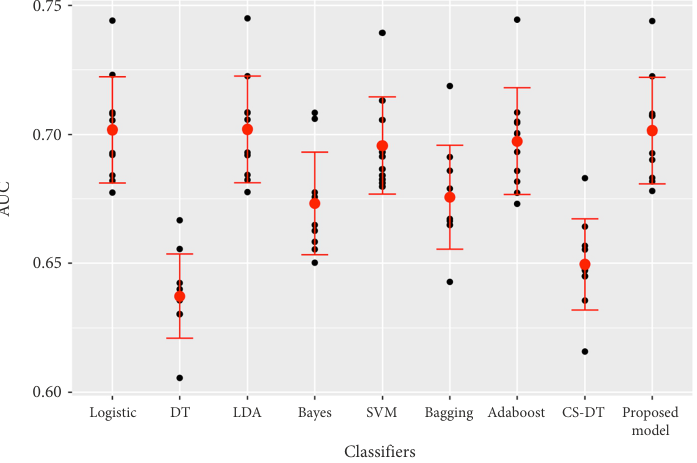
Figure 16. AUC boxplot for the lending club dataset